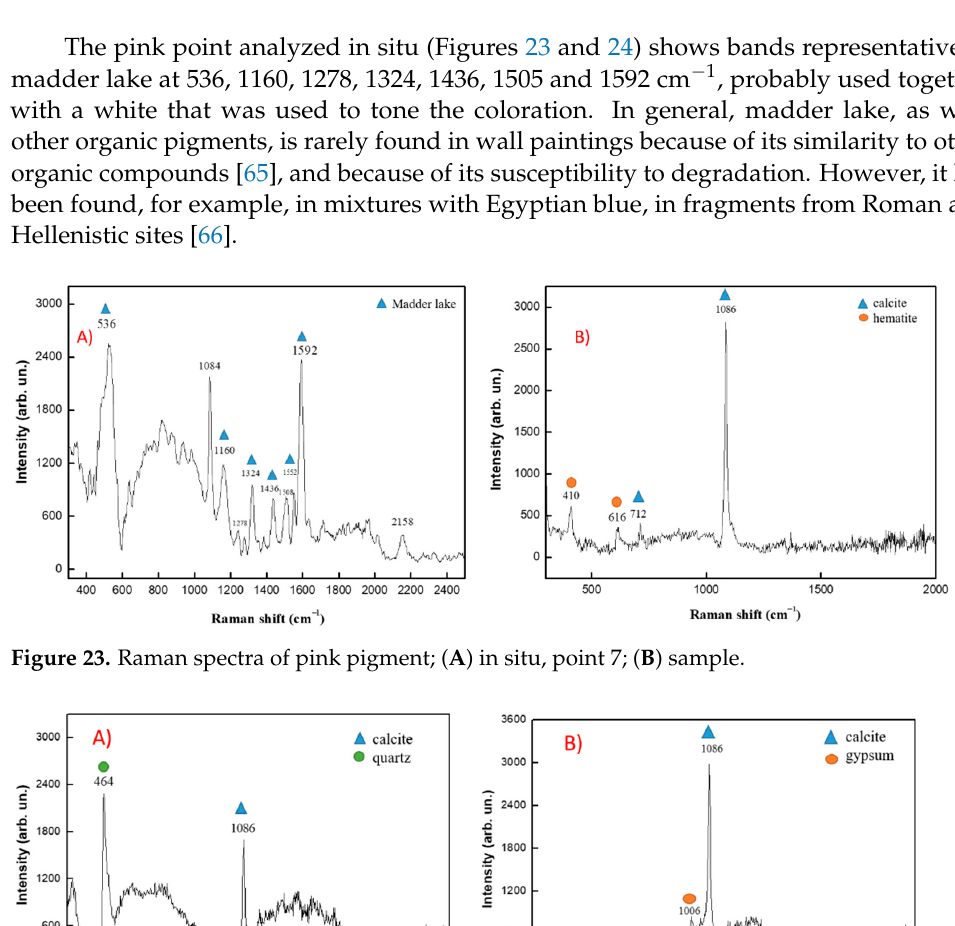
Figure 24 . Raman spectra of ( A ) yellow, point 4 and ( B ) black–blue, point 2 Figure 24. Raman spectra of ( A ) yellow, point 4 and ( B ) black–blue, point 2. On the contrary, the pink pigment analyzed in the sample shows the typical band of hematite together with calcite. For yellow and black–blue the Raman spectra showed only calcite, quartz (464 cm − 1 ) and gypsum (1006 cm − 1 ). Neither case gave significant